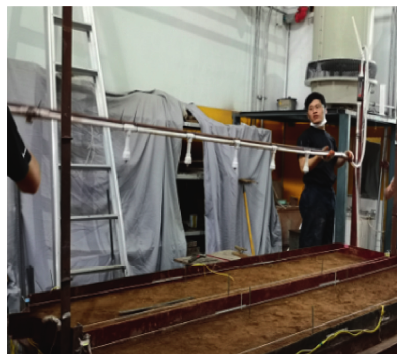
Figure 4: Rainfall simulation sprayers installed above the